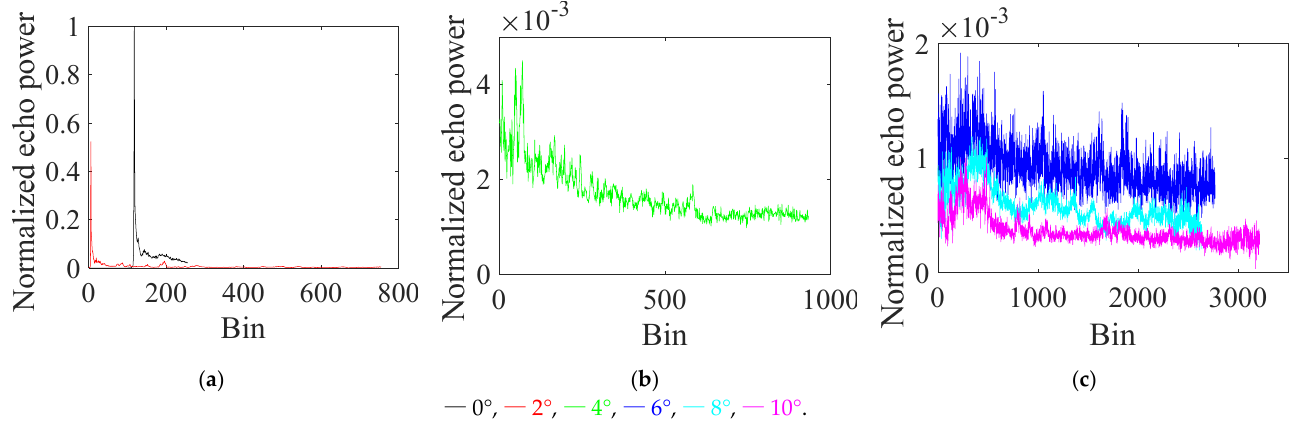
Figure 3. Echo waveforms of FYI at the six small incidence angles: ( a ) 0°–2°; ( b ) 4°; ( c ) 6°–10°.